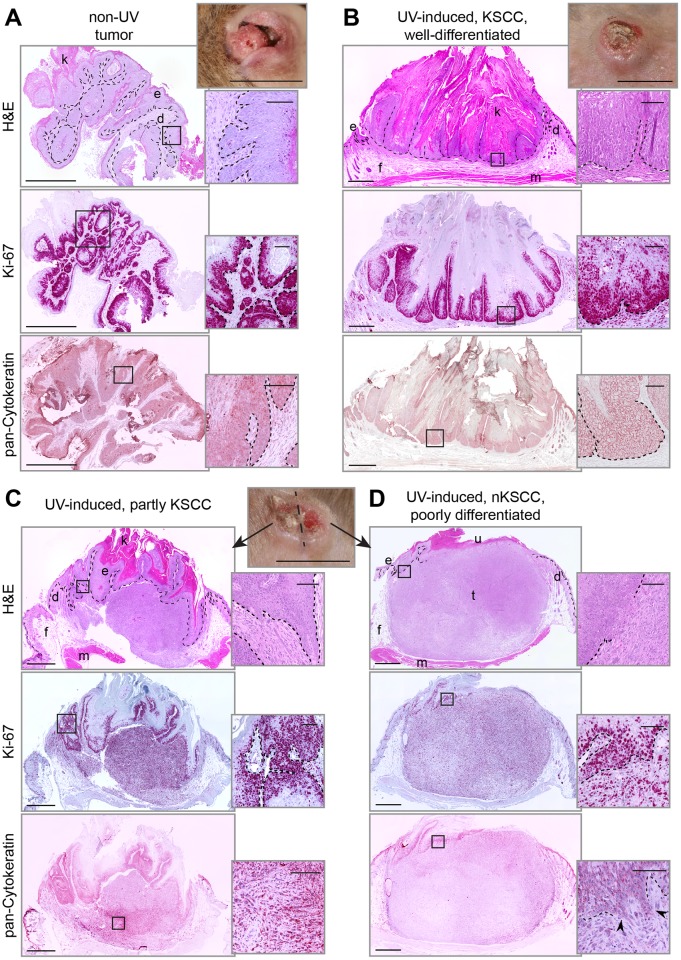
Histological analyses of a non-UV tumor and UV-induced tumors.A) Tumors from unirradiated sites show papilloma-like growth of well-differentiated neoplastic squamous cells (H&E). Especially the basal layers are hyperproliferative as indicated by strong Ki-67 staining. Throughout all layers of the lesion, neoplastic cells strongly express cytokeratins (pan-Cytokeratin). B) A UV-induced KSCC with well-differentiated exoendophytic proliferations of squamous cells expressing Ki-67 throughout all neoplastic squamous layers. C and D) In some cases well-differentiated KSCCs (C) further developed into more aggressive poorly differentiated nKSCCs (D). Proliferating altered squamous cells thereby invaded deeper layers and often changed to a spindle-like phenotype (H&E). The Ki-67 staining becomes diffuse in this process (compare insets) and cytokeratin expression is reduced. (d: dermis; e: epidermis; f: fat; k: keratin; m: muscle; u: ulceration; t: tumor. Scale bars: macroscopic: 10 mm, overviews: 1 mm, insets 100 μm).